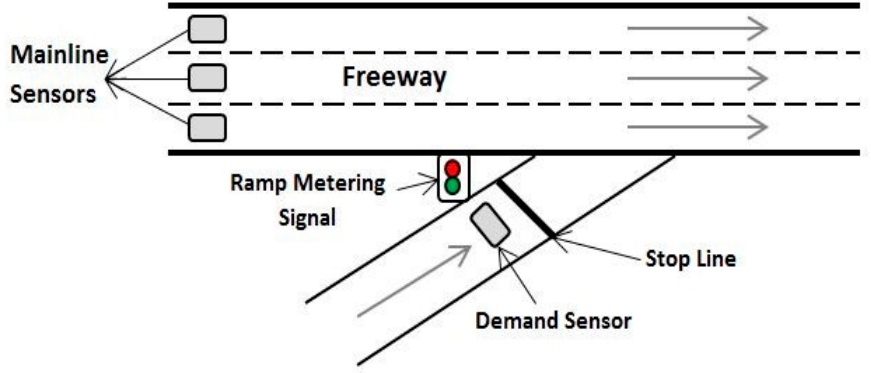
Figure 1. A typical ramp metering system.